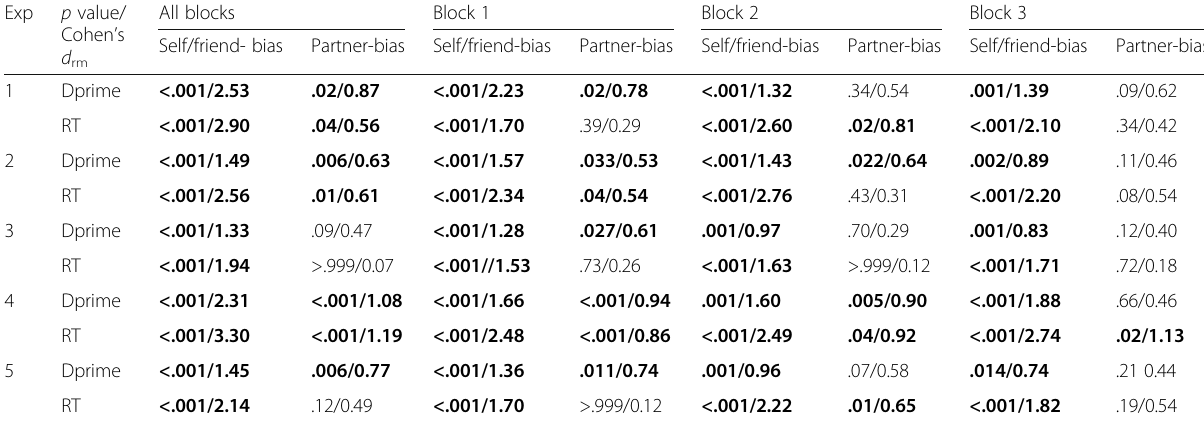
Table 2 Planned pairwise test results ( p value and effect size of Cohen ’ s d rm ) with post-hoc Bonferroni adjustments on the d prime ( d ’ ) and response time (RT) of matched trials of averaged data across blocks and block-by-block data, and in all experiments Exp p value/ Cohen ’ s d